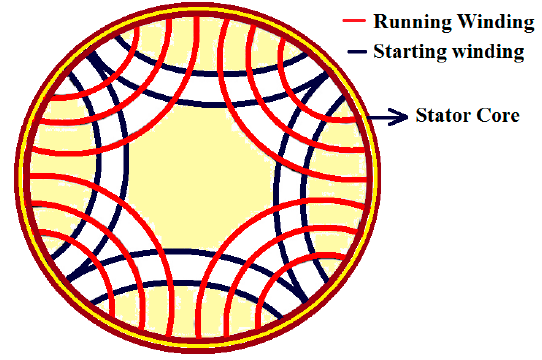
Figure 5. Placement of single phase windings on the stator.